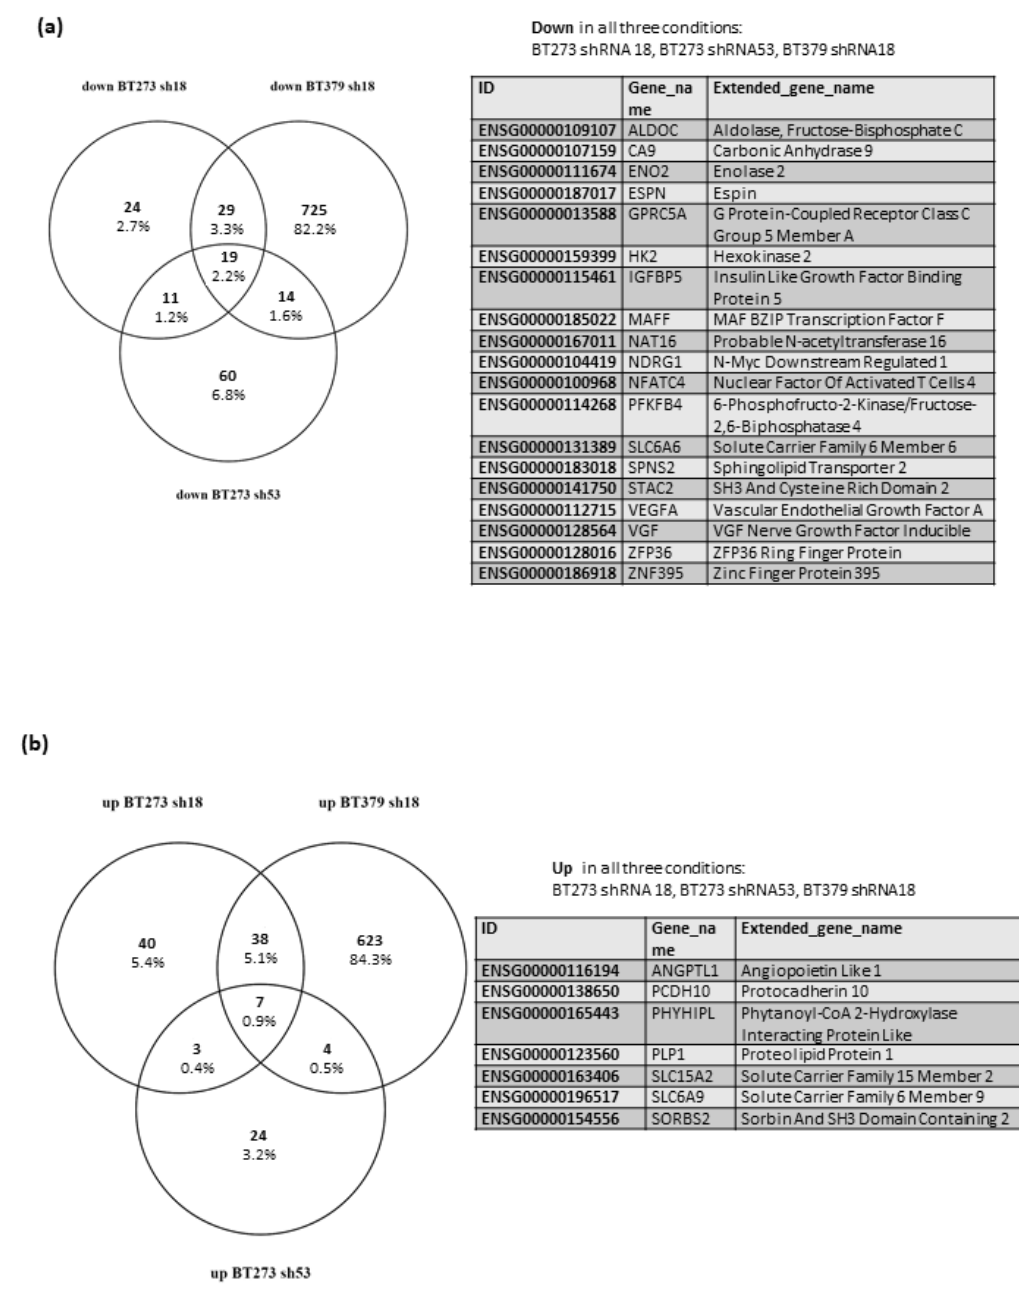
Figure 3. MEOX2 knock down in glioblastoma stem cells differentially modulates gene expression in different cells, but consistently affects some subsets. ( a , b ) Venn diagrams showing the numbers and percentages of DEGs (absolute log2 fold change ≥ 0.7, adjusted p -value ≤ 0.05) in BT273 or BT379 cells transduced with either shRNA18 or shRNA53, compared to the same cell types transduced with a negative control. Panel a shows the downregulated genes, and panel b the upregulated ones. Each diagram is flanked, on the left, by the list of genes consistently modulated in all three conditions, i.e., BT273 shRNA 18, BT273 shRNA53, BT379